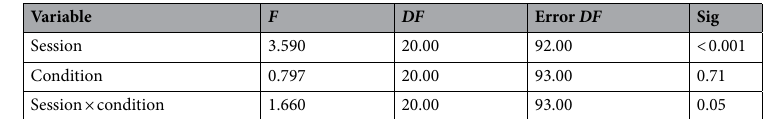
Table 2. MANOVA results in controls. Dependent variable: 20 fNIRS channels for oxyhemoglobin level, factors: Condition (Resting State vs Grasping Flat vs Grasping Sharp-tip object) and Session (Time-to-contact detection vs Observation-only).